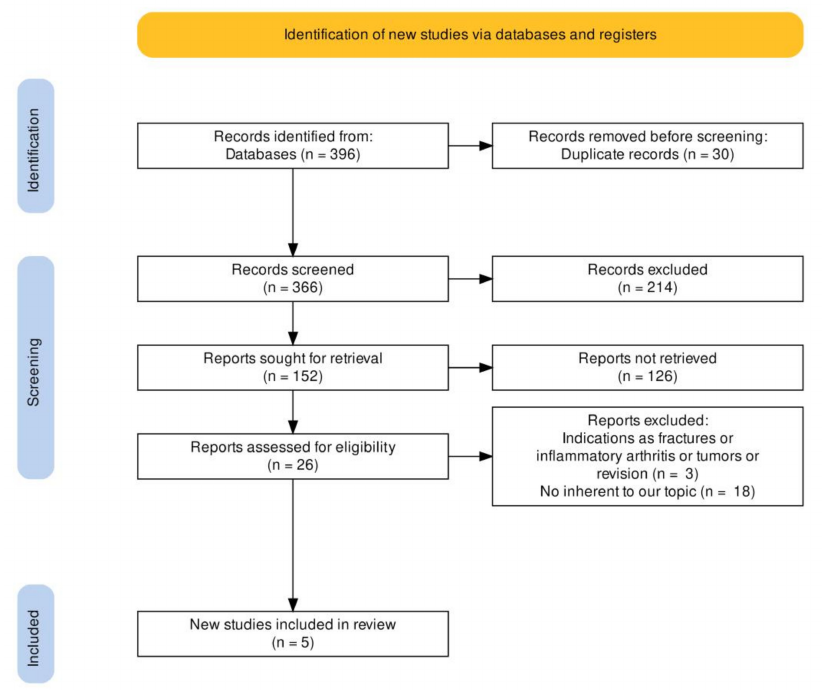
Figure 1. PRISMA flowchart.